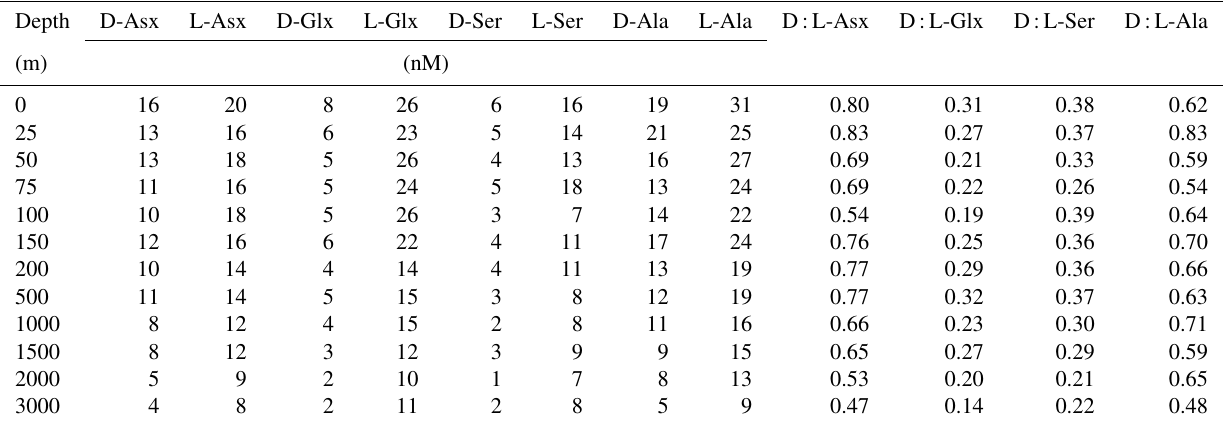
Figure 5. Average concentrations of total hydrolyzable L- and D-enantiomers of asparagine + aspartic acid (Asx), glutamine + glutamic acid (Glx), serine (Ser), and alanine (Ala) concentrations in the EJS, and the average D:L ratios for these amino acids. Table 2. Average concentrations of D- and L-enantiomers of aspartic acid and asparagines (D- and L-Asx), glutamic acid and glutamine (D- and L-Glx), serine (D- and L-Ser), and alanine (D- and L-Ala) and the enantiomeric D:L